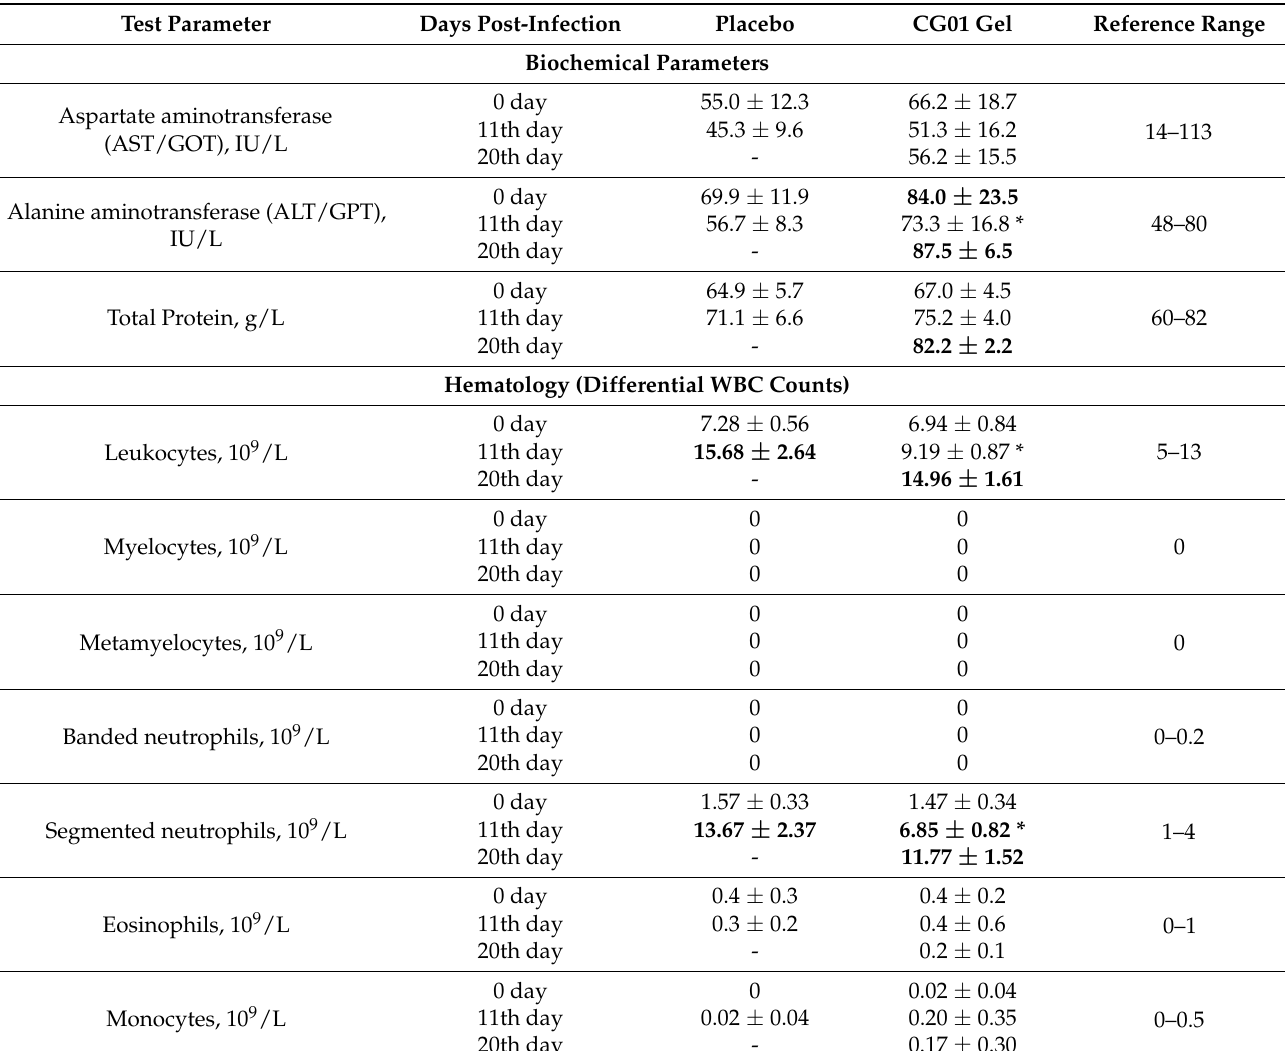
Blood samples at three time points (before the infection, and on the 11th and 20th days after infection) were analyzed for differential WBC counts and biochemical (ALT/GPT, AST/GOT, and total protein) parameters (Table 4). As no animals in the placebo group were alive by the 20th day after the infection, no data are provided for this group. Table 4. Clinical chemistry and hematology test results from rabbits in the two investigated groups. Test